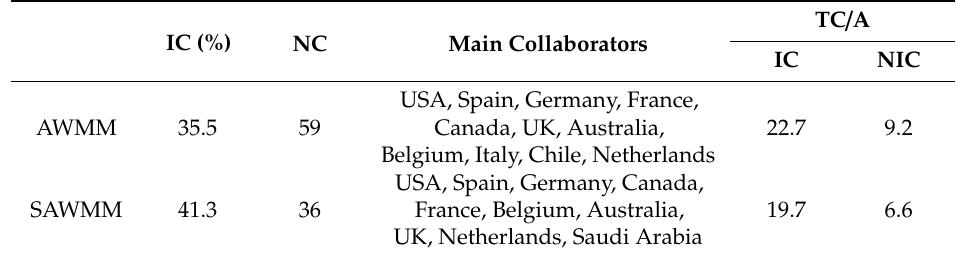
Table 5. Main characteristics of the international collaboration of Mexico related to AWMM and SAWMM research.